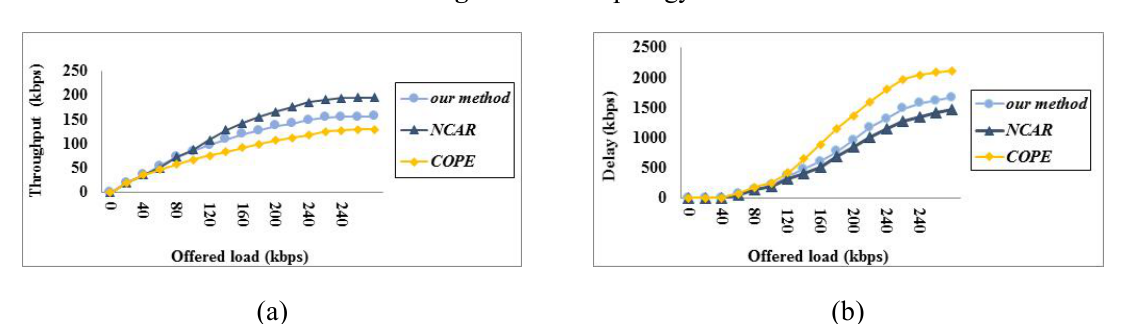
Fig. 4. Results from a random topology with 50 nodes. (a) Average throughput. (b)Average end to end delay